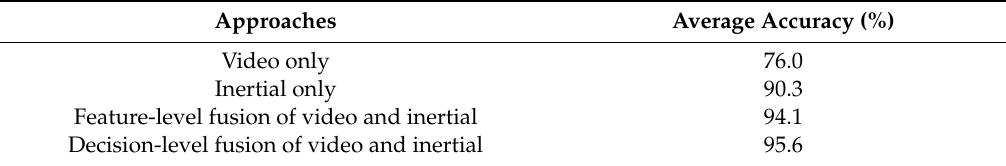
Table 4. Average accuracy of video sensing modality only, inertial sensing modality only, feature-level fusion of video and inertial sensing modalities, and decision-level fusion of video and inertial sensing